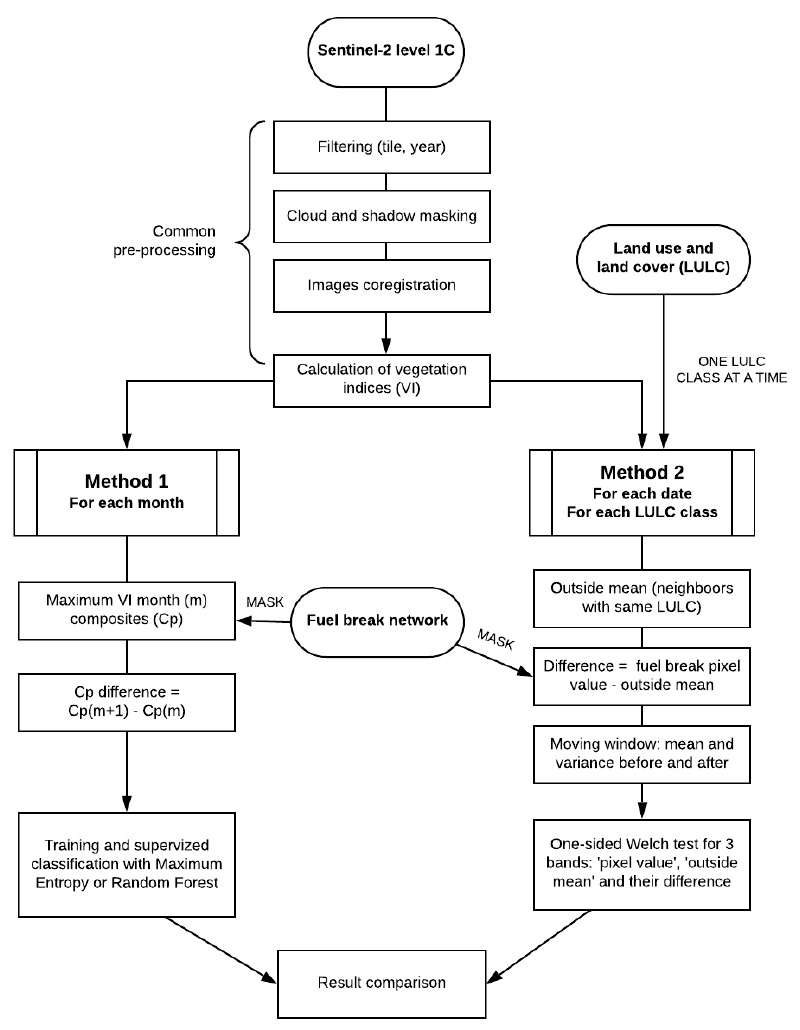
Figure 3. Flowchart including the common preprocessing and the two methodologies.